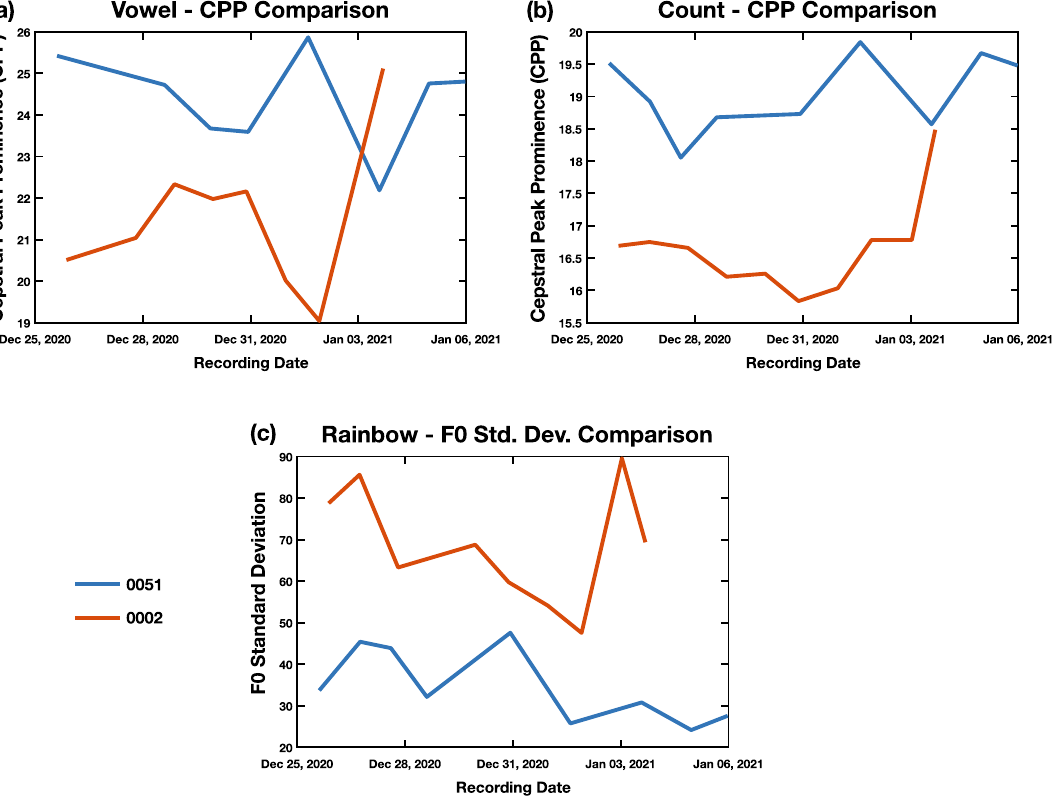
Figure 5. Case study comparisons of CPP and F0 between subjects 0051 and 0002. ( a ) CPP values over time for subjects 0051 (COVID-19 negative) and 0002 (COVID-19 positive) for the Vowel task. We see an increase in CPP at the end of the recording period of Subject 0002, reaching a CPP level which is close to the CPP value of Subject 0051. ( b ) CPP values over time for subjects 0051 and 0002 for the Count task. We similarly see an increase in CPP at the end of the recording period of Subject 0002, leading to a CPP value close to that of Subject 0051. This suggests that vocal fold vibration stability is increasing as Subject 0002 is recovering in both tasks. ( c ) This figure plots the values of the standard deviation of F0 during the Rainbow task for subjects 0051 (COVID-19 negative) and 0002 (COVID-19 positive). The standard deviation for Subject 0051 is lower than that of Subject 002, suggesting more stability in F0 contours during the